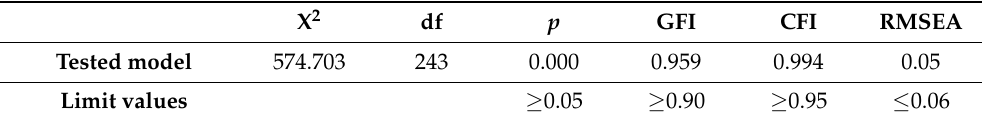
Table 4. Indicators of suitability of the tested